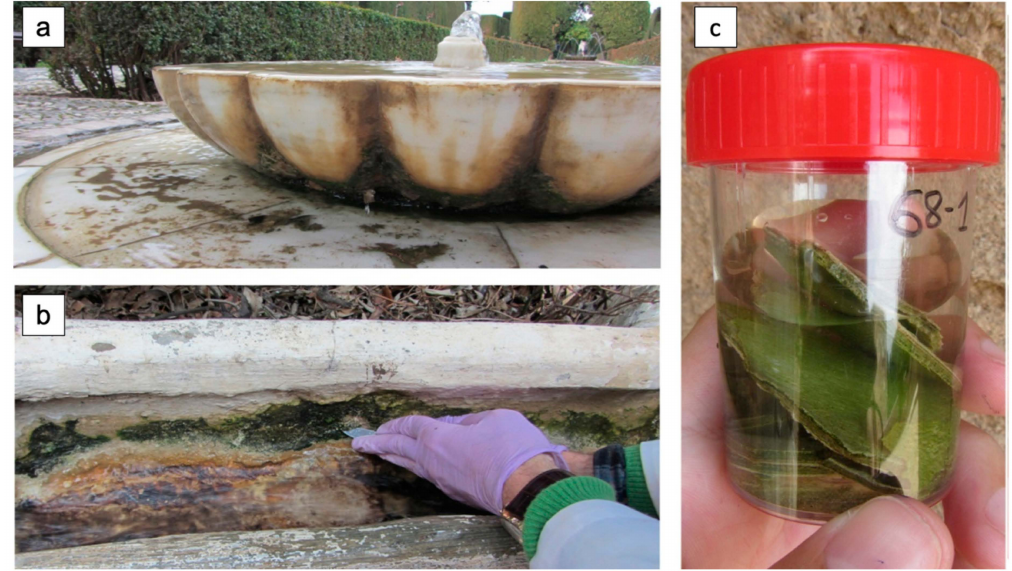
Figure 5. ( a ) South fountain of the Lower Gardens. The base of the basin, where a dark green mat can be seen, was one of the sampling points; ( b ) Taking a sample of mineral crust in the Escalera del Agua (Water Stairway); ( c ) Sample of mineral crust taken in the Washington Irving basin. Photos by G.